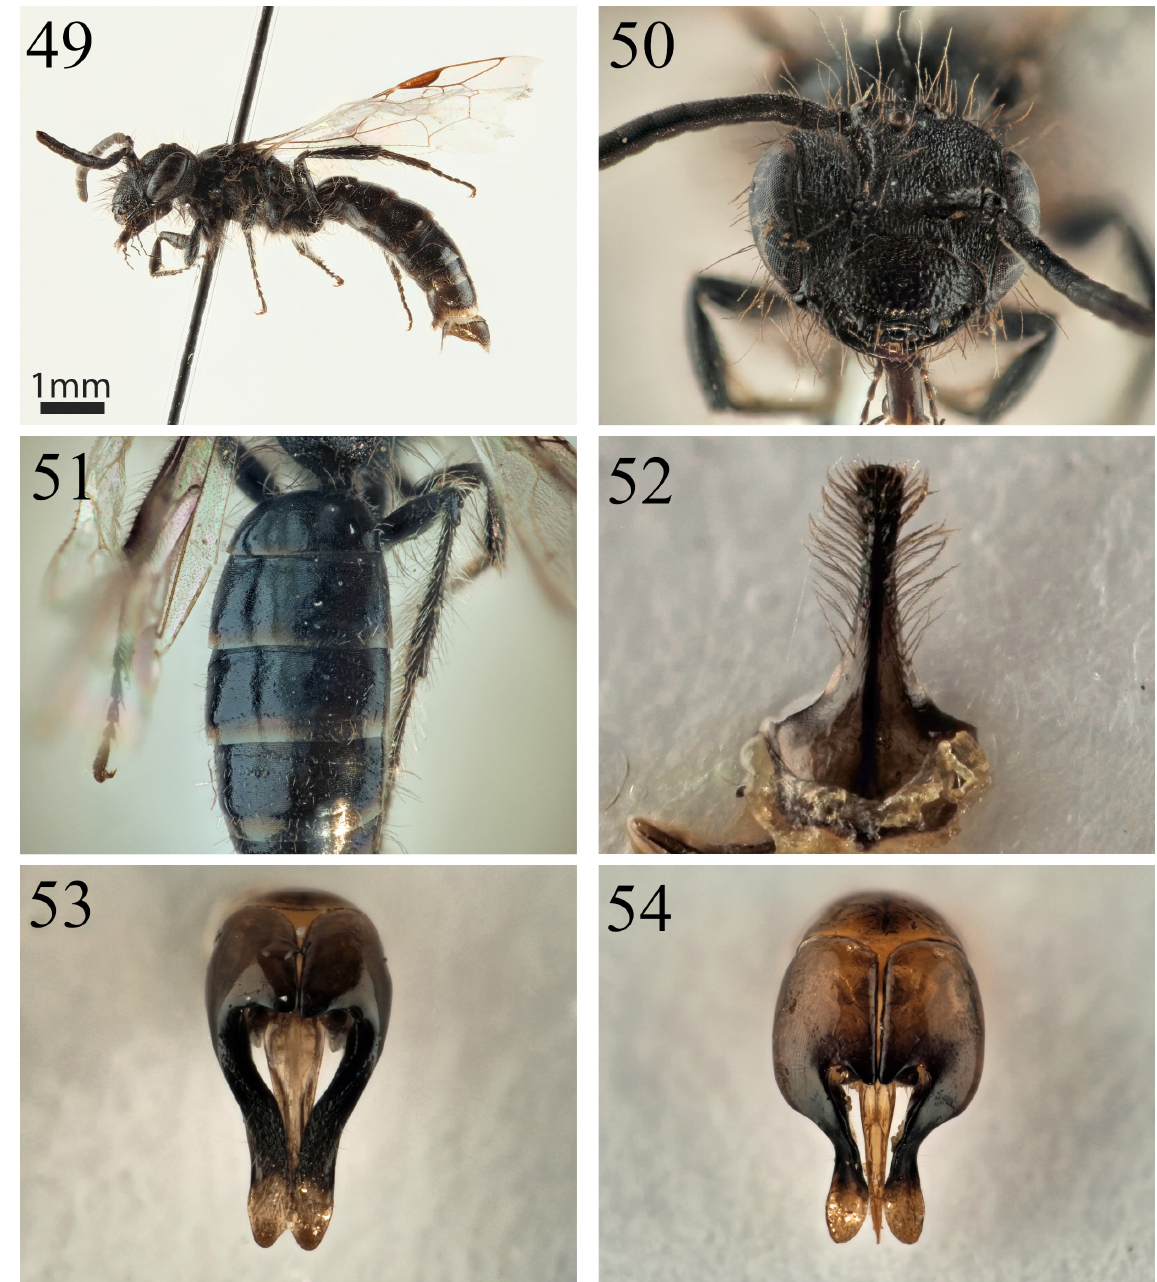
Figs 49–54. 49–53 . Andrena extenuata sp. nov., ♂ (OÖLM). 49 . Profile. 50 . Face. 51 . Terga. 52 . Sternum 8. 53 . Genitalia. – 54 . Andrena djelfensis Pérez, 1895, ♂